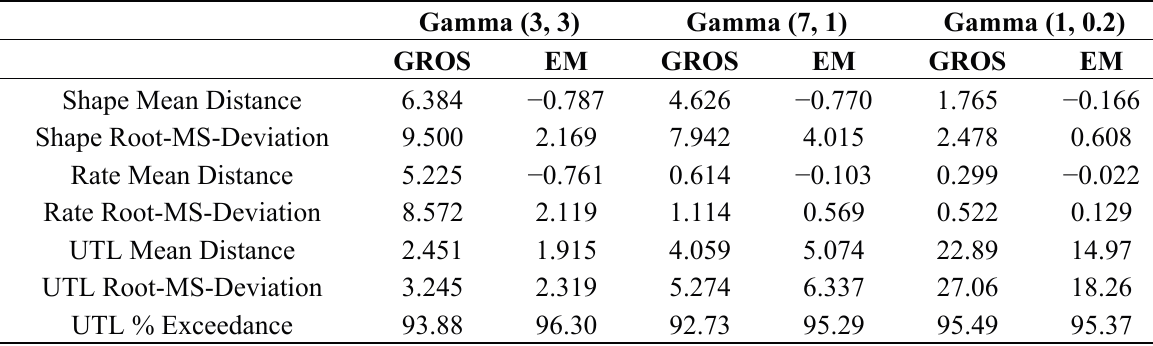
Table A1. Simulation results showing mean distances and root mean squared deviations from the true parameter values. UTL measures are from the 95 th percentile of the true distribution. UTL % exceedance is the percentage of 95%–95% UTLs that exceeded the 95th percentile of the true